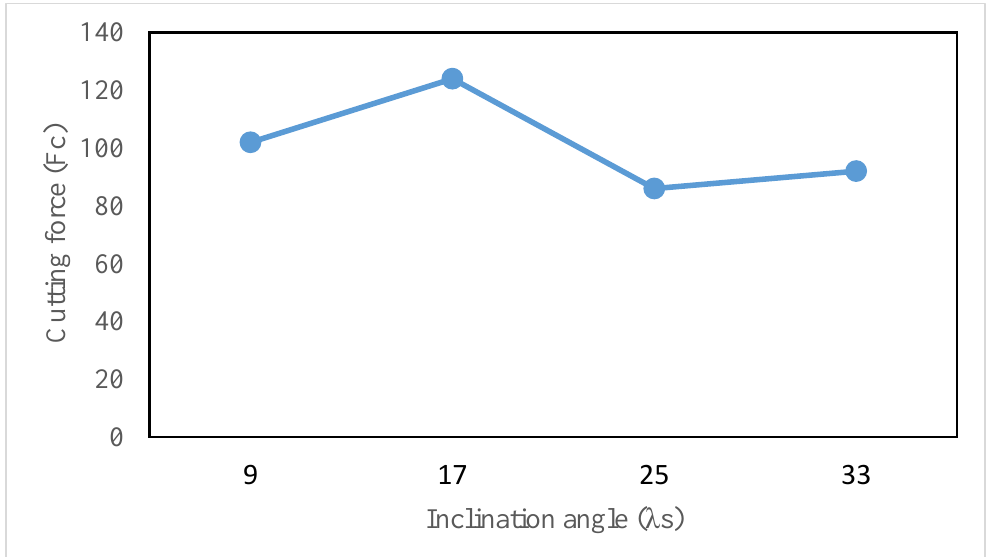
Figure 9. Chip formation at different inclination angles ( V = 100 m/min).